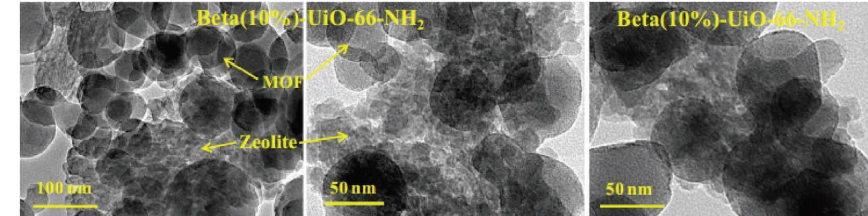
Figure 17: TEM images of Beta (10%)-UiO-66-NH